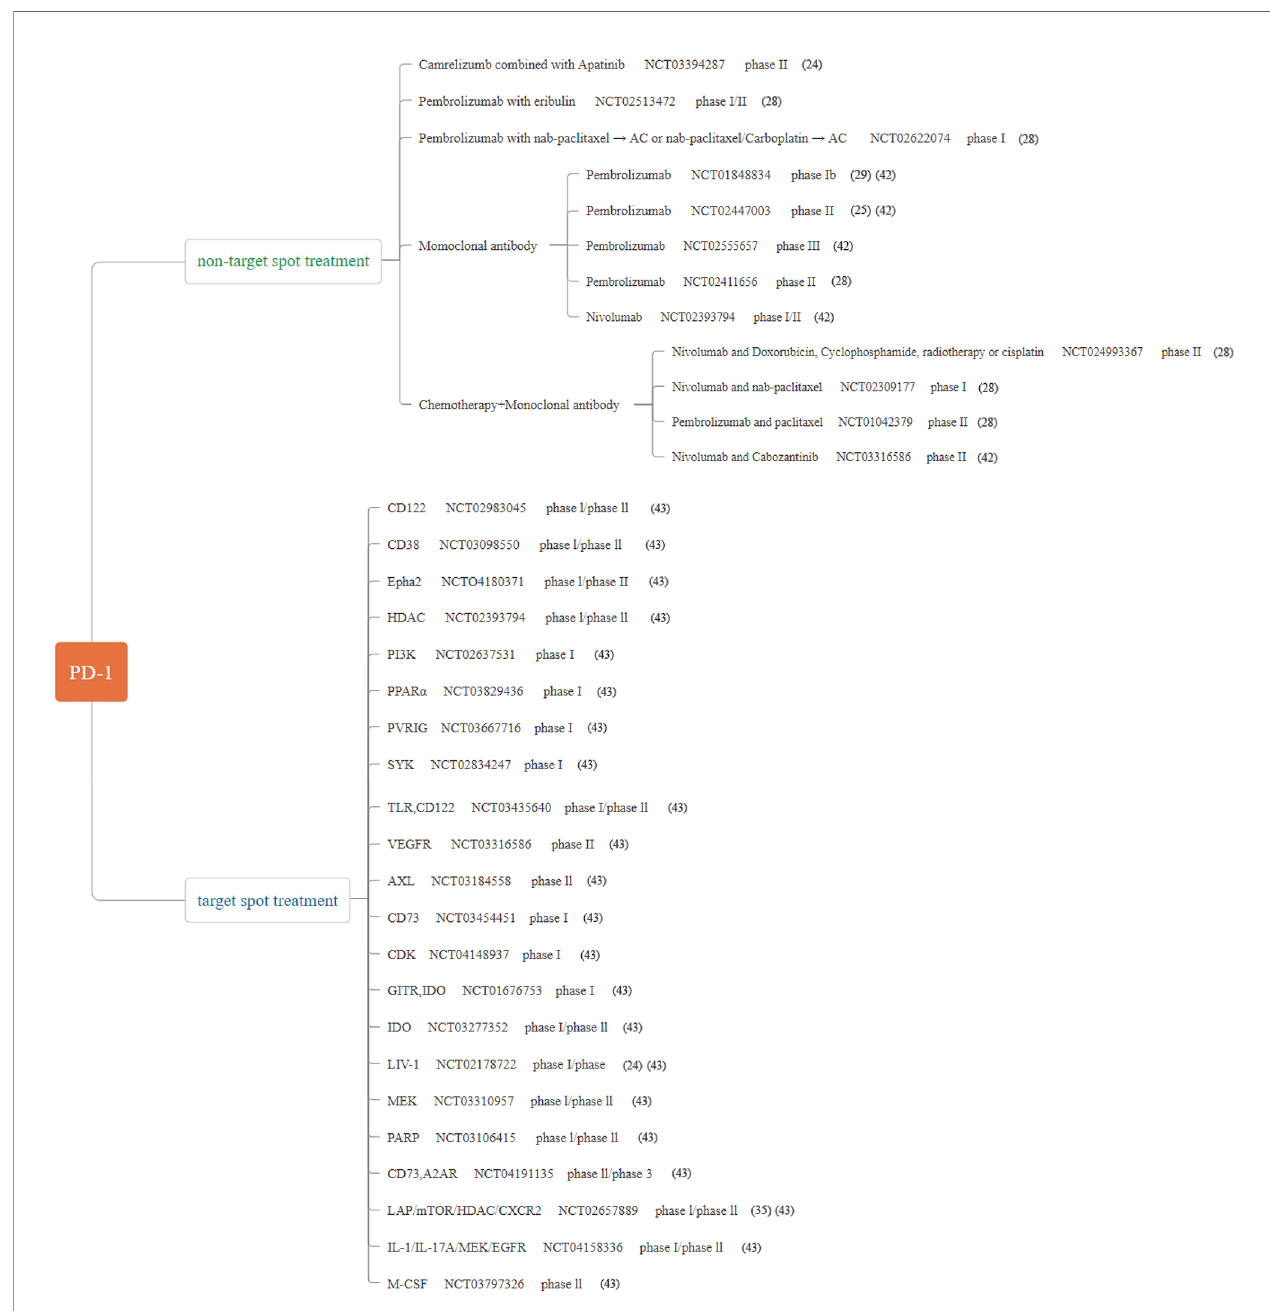
FIGURE 2 | Major published clinical trials using PD-1 inhibitors in